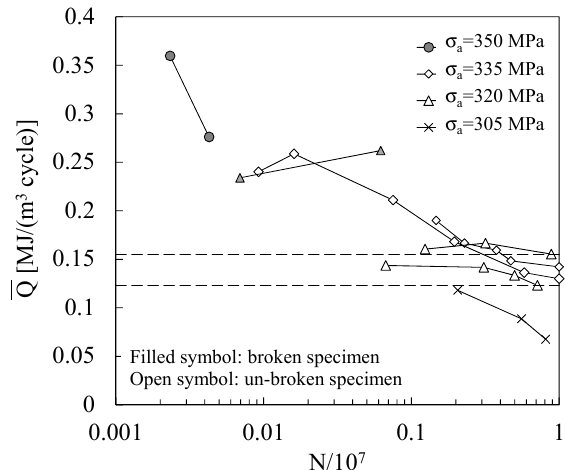
Figure 11. Q trends vs the number of cycles normalized with respect to 10 million.